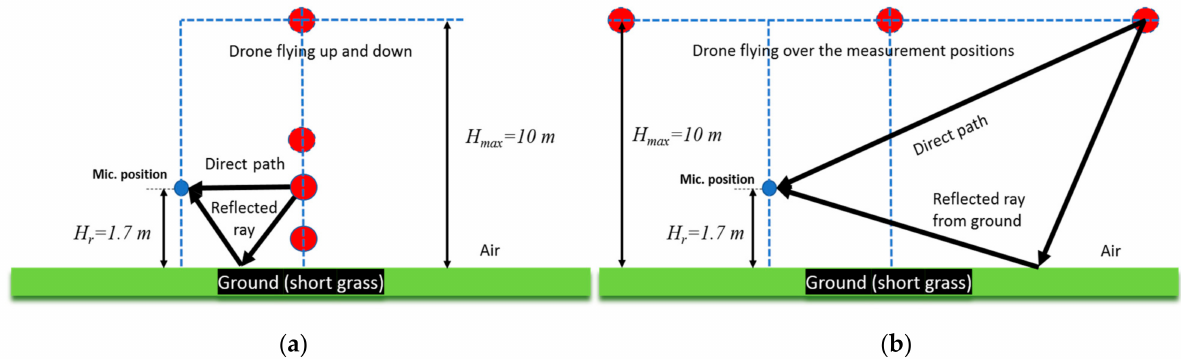
Figure 2. The measurement situations with microphone position and initial flying point for the two procedures: ( a ) flying up and down; ( b ) flying